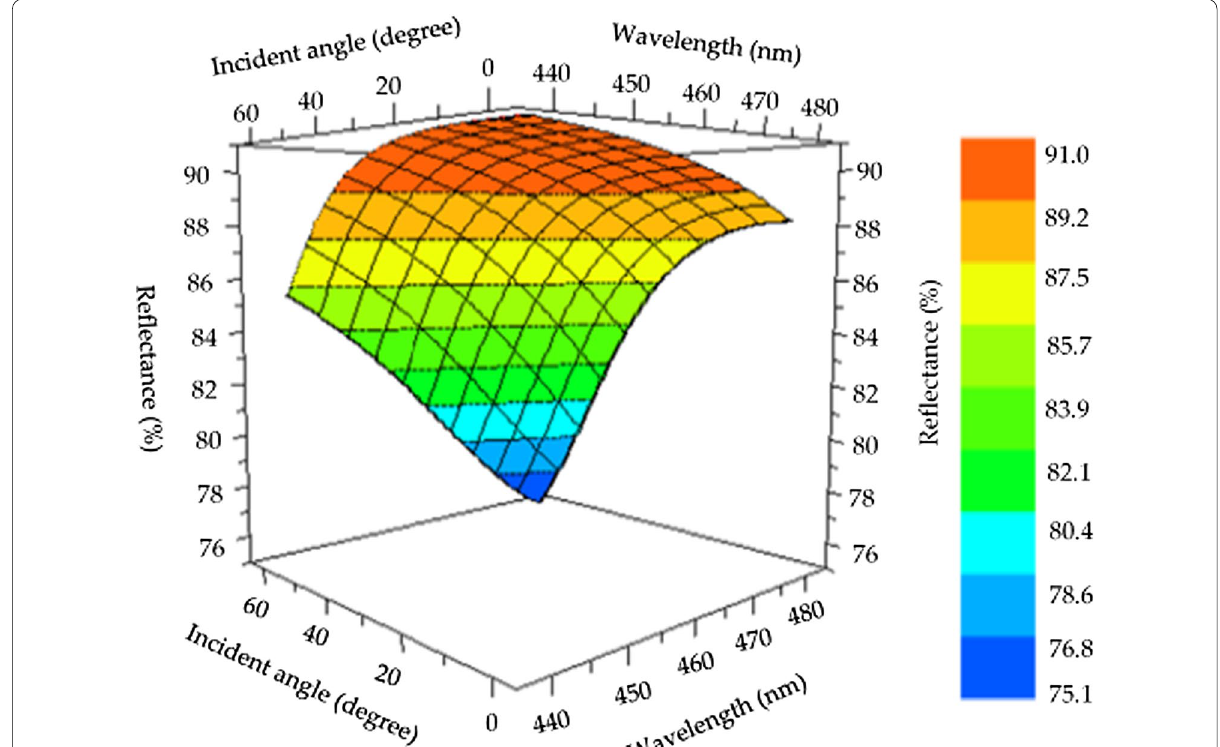
Fig. 6. 3D relationship diagram of the simulated wavelengths, incident angles, and reflectivity of Al/(HL) 2